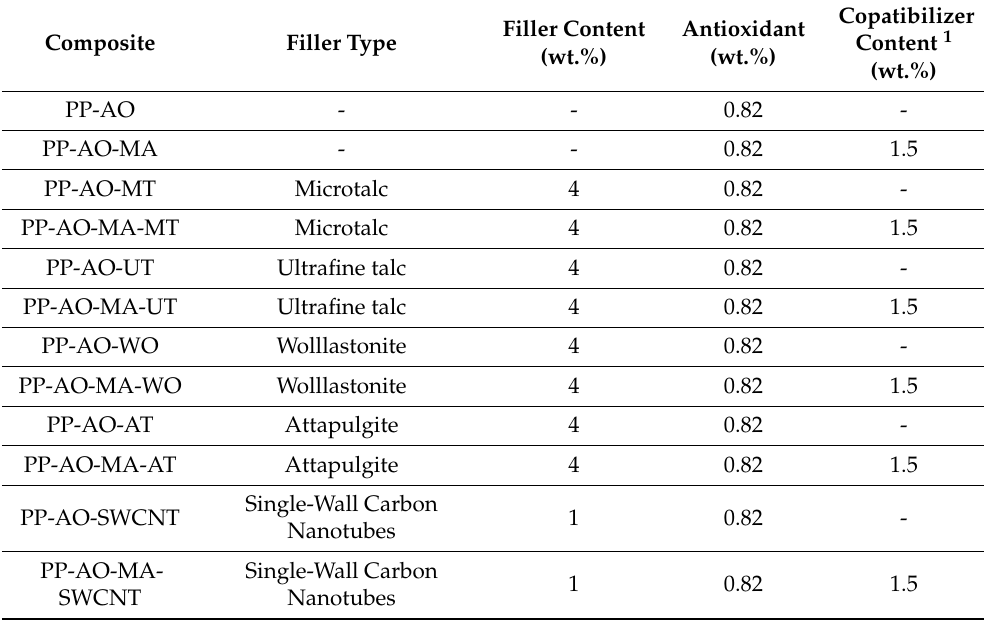
Table 2. Prepared composites and their composition.